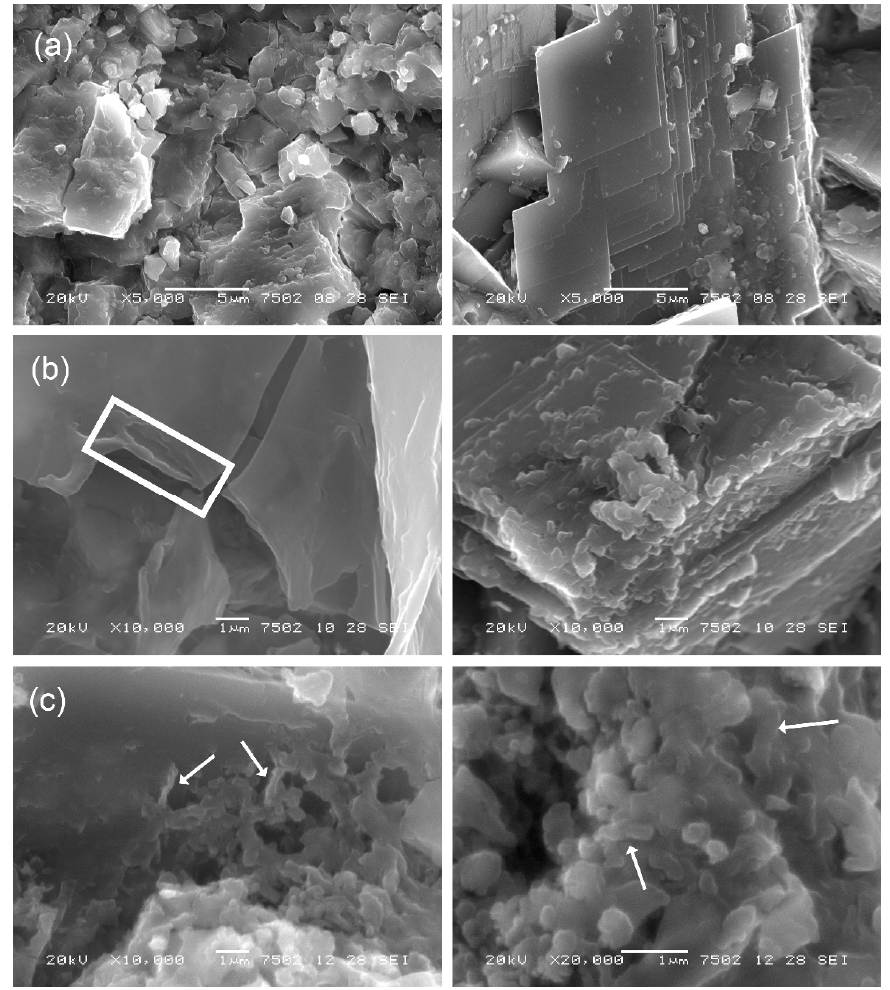
Figure 2. SEM images of Angera stone. ( a ) Untreated substrate, showing micritic dolomite on the left and bigger grains of well-shaped rhombohedral dolomite on the right; ( b ) treated lithotype after the poultice with a 0.76 M DAP solution. On the left, pseudo-amorphous coating formed on micritic dolomite and incipient formation of spherical structures in an elongated arrangement (white rectangle); on the right, big dolomitic crystal with the overgrowth of crystal agglomerates in spherical structures, some of them having prismatic elongations; ( c ) treated Angera stone after the poultice with a 3.00 M DAP solution, showing detail of spherical crystallites and their aggregation in chains - elongated arrangement (arrows).